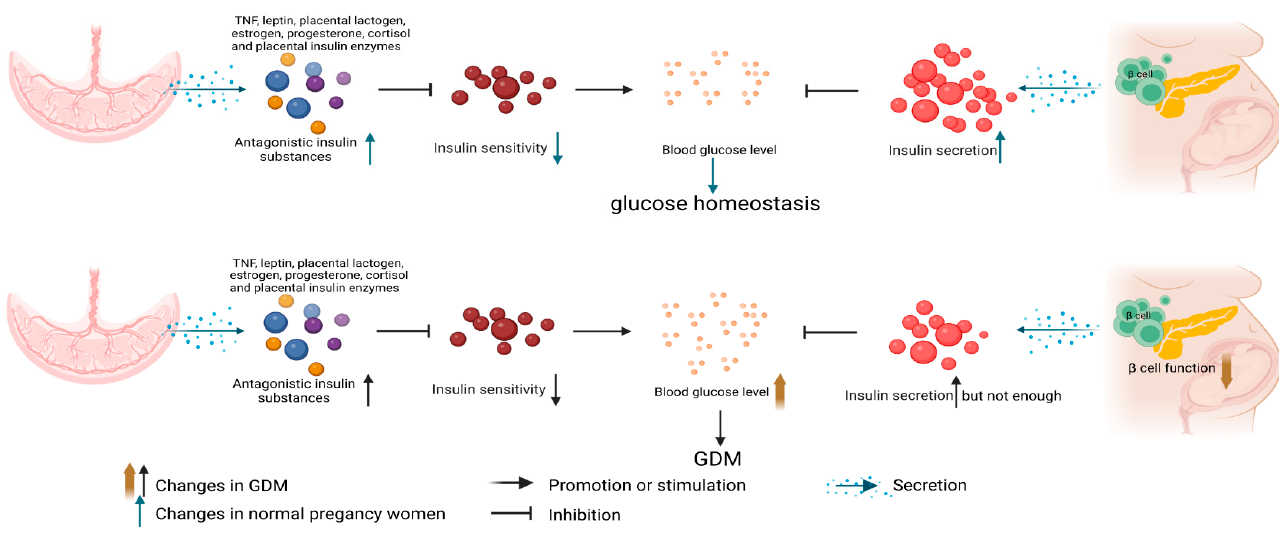
Figure 1. Pathogenesis of GDM. The images in this figure were taken from https://biorender.com/ (accessed on 22 November 2022).